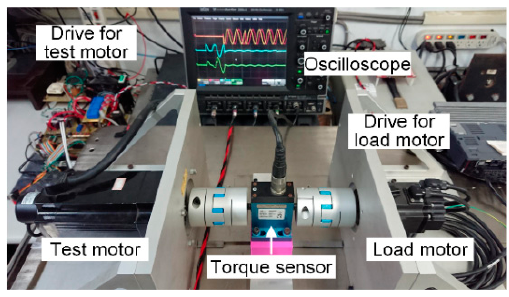
Figure 10. Experimental system.